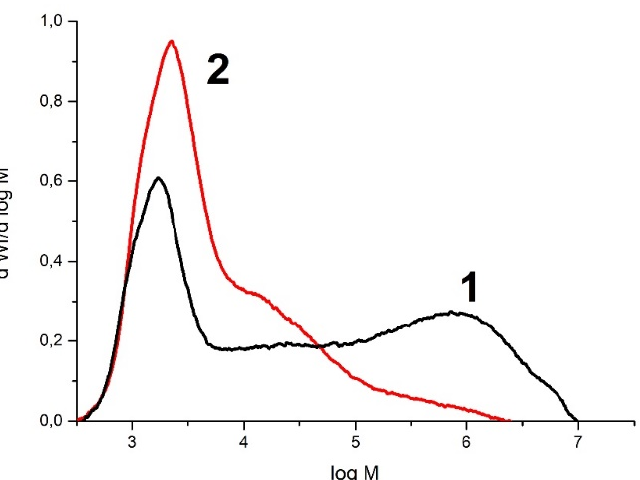
Figure 8. MWD curves for polymers obtained from ethylene polymerization over catalytic system *LFeCl 2 /MMAO + TMA in the absence of hexene-1 (curve 1) and in the presence of hexene-1 (curve 2) (for data on the polymerization, see Table 5). Table 5. Comparative data on the ethylene polymerization over catalyst *LFeCl 2 /MMAO + TMA in the absence of hexene-1 (exp. 1) and in the presence of hexene-1 (exp. 2).